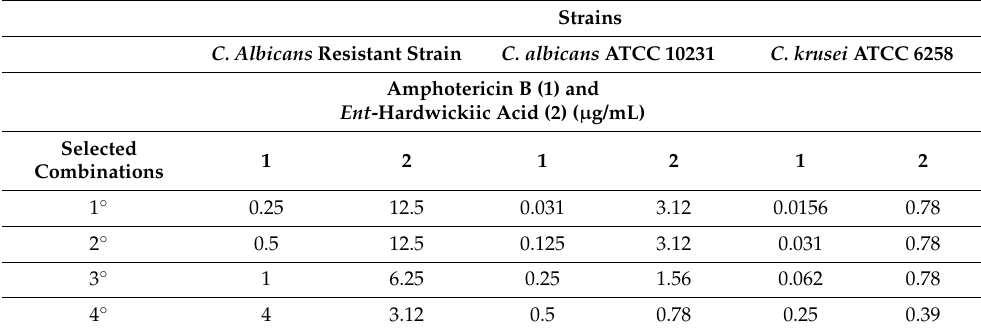
Table 2. Selected concentrations of amphotericin B (1) and ent -hardwickiic acid (2) ( µ g/mL) based on the checkerboard assay for time–kill assays of Candida